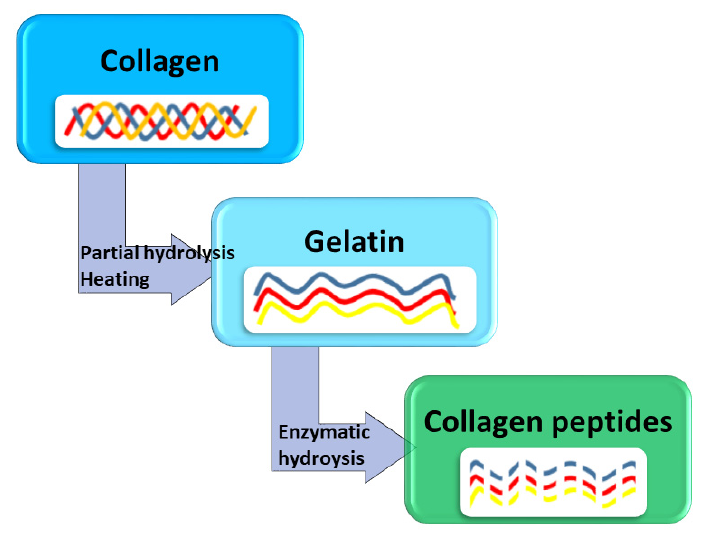
Figure 4. Collagen and its derivatives.